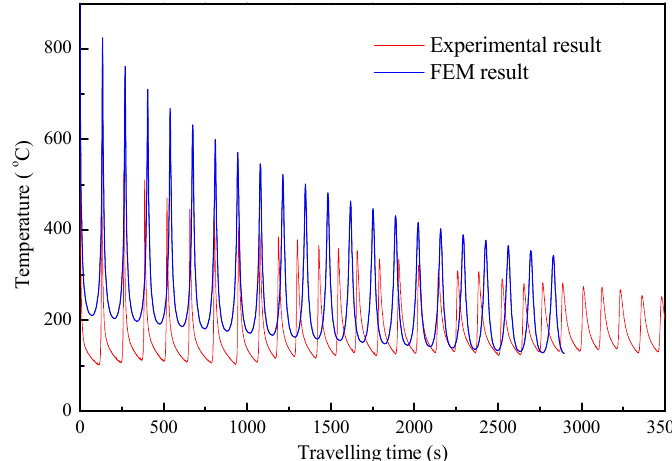
Figure 4. Comparison of the finite element calculations with the experimental results.